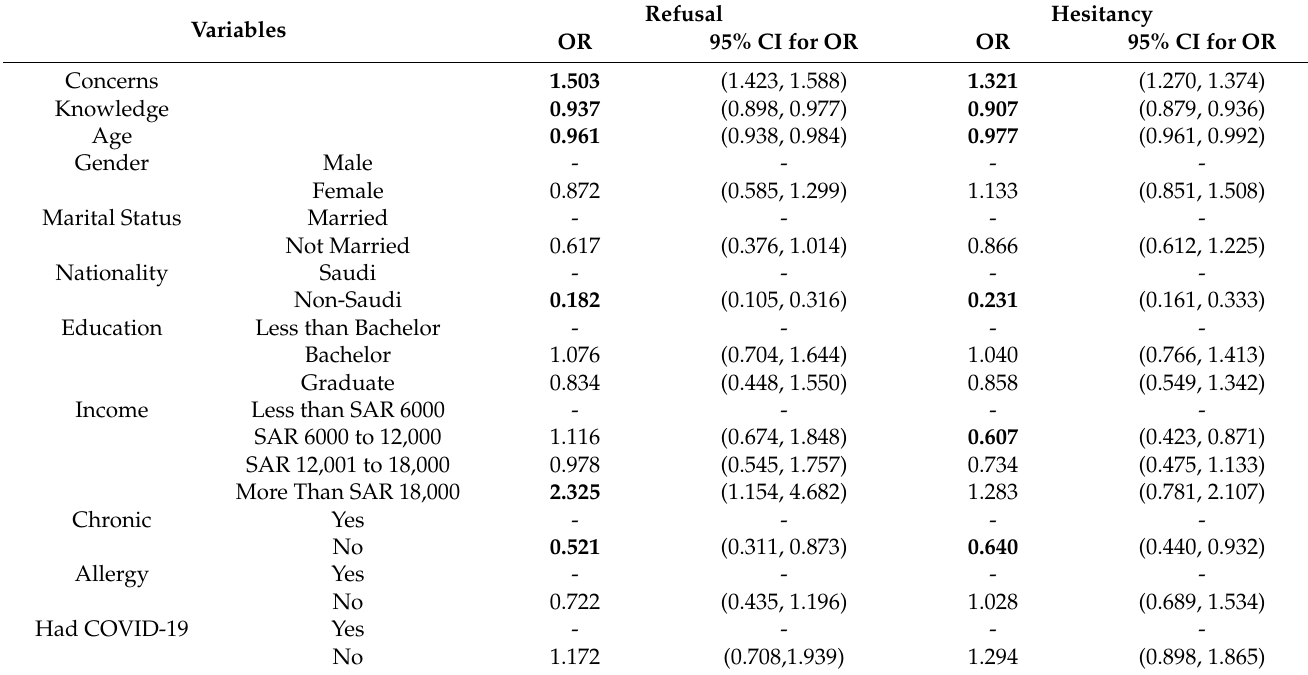
Table 4. Multinomial logistic regression for predictors of refusal and hesitancy to uptake the COVID-19 vaccine.